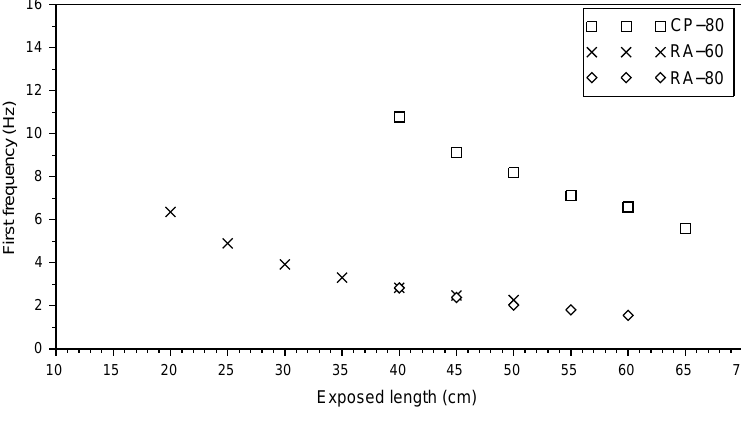
Figure 6. Variation of first frequency with exposed length in clayey soil. Table 6. Sensitivity of the frequencies of the tested rods to scour in sand and clayey soil. Tested Rods Flexural Rigidity N.m